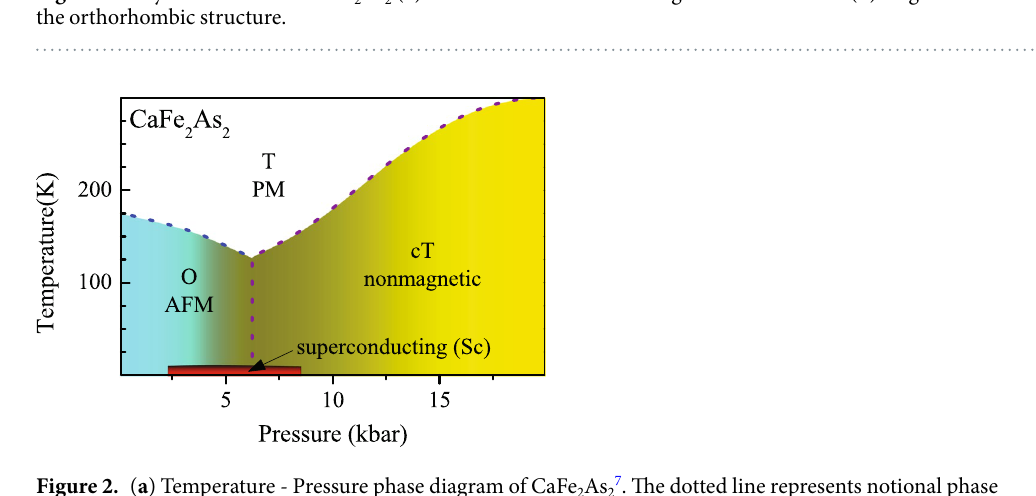
Figure 2. ( a ) Temperature - Pressure phase diagram of CaFe 2 As 27 . The dotted line represents notional phase boundary between various structural and magnetic